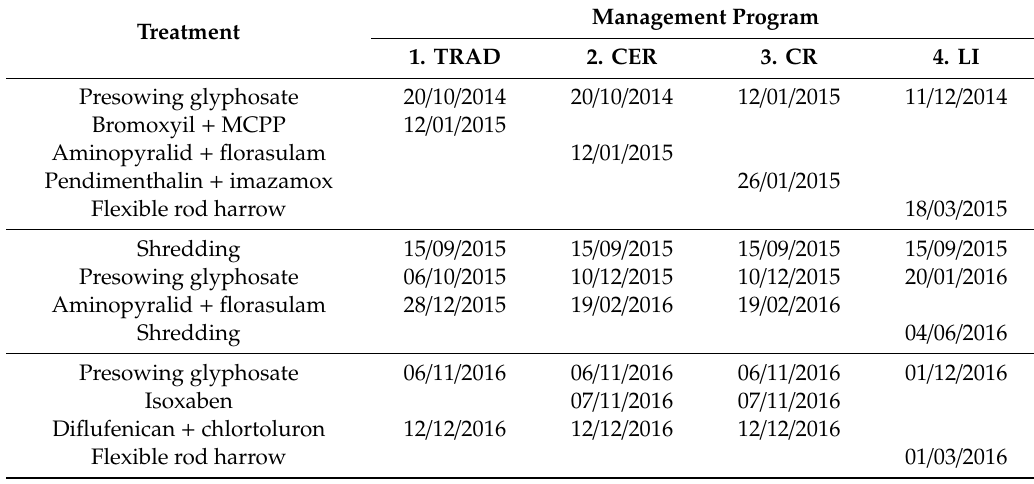
Table 8. Dates of herbicides application and mechanical control in each management